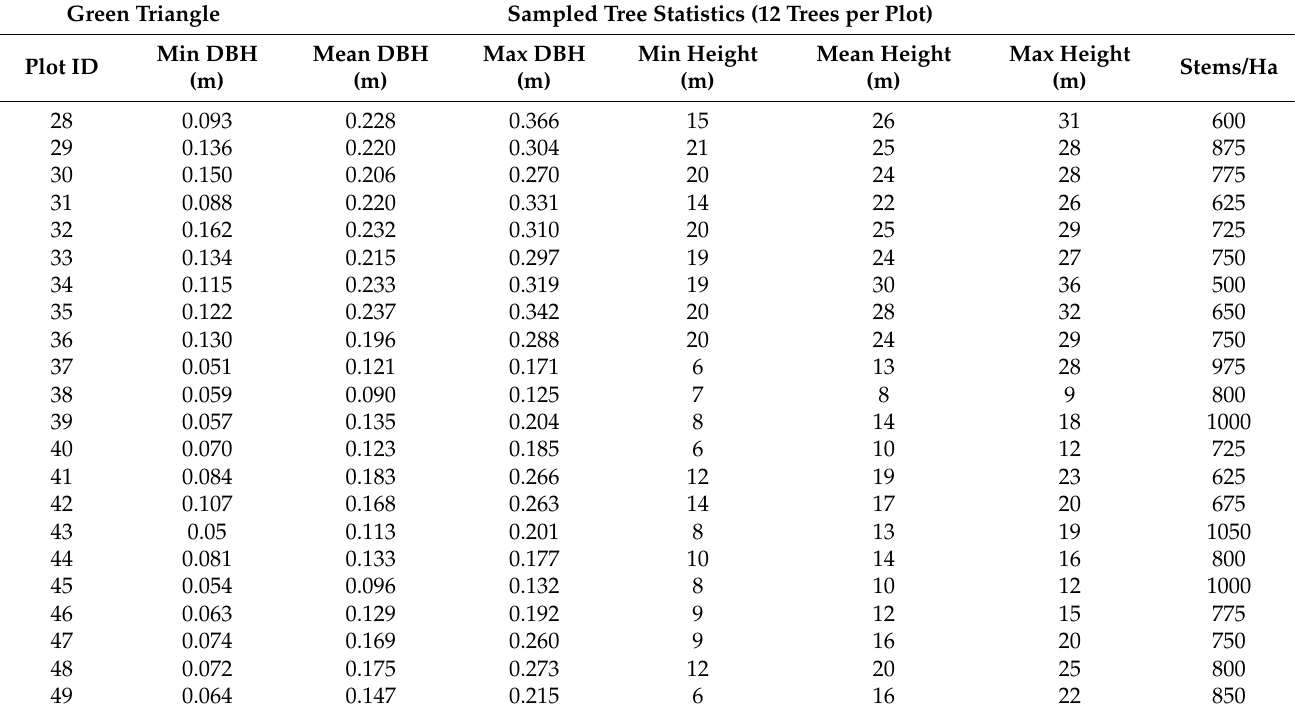
Table 2. Sampled stem statistics for the 22 Green Triangle (Victoria and South Australia) plots. Green